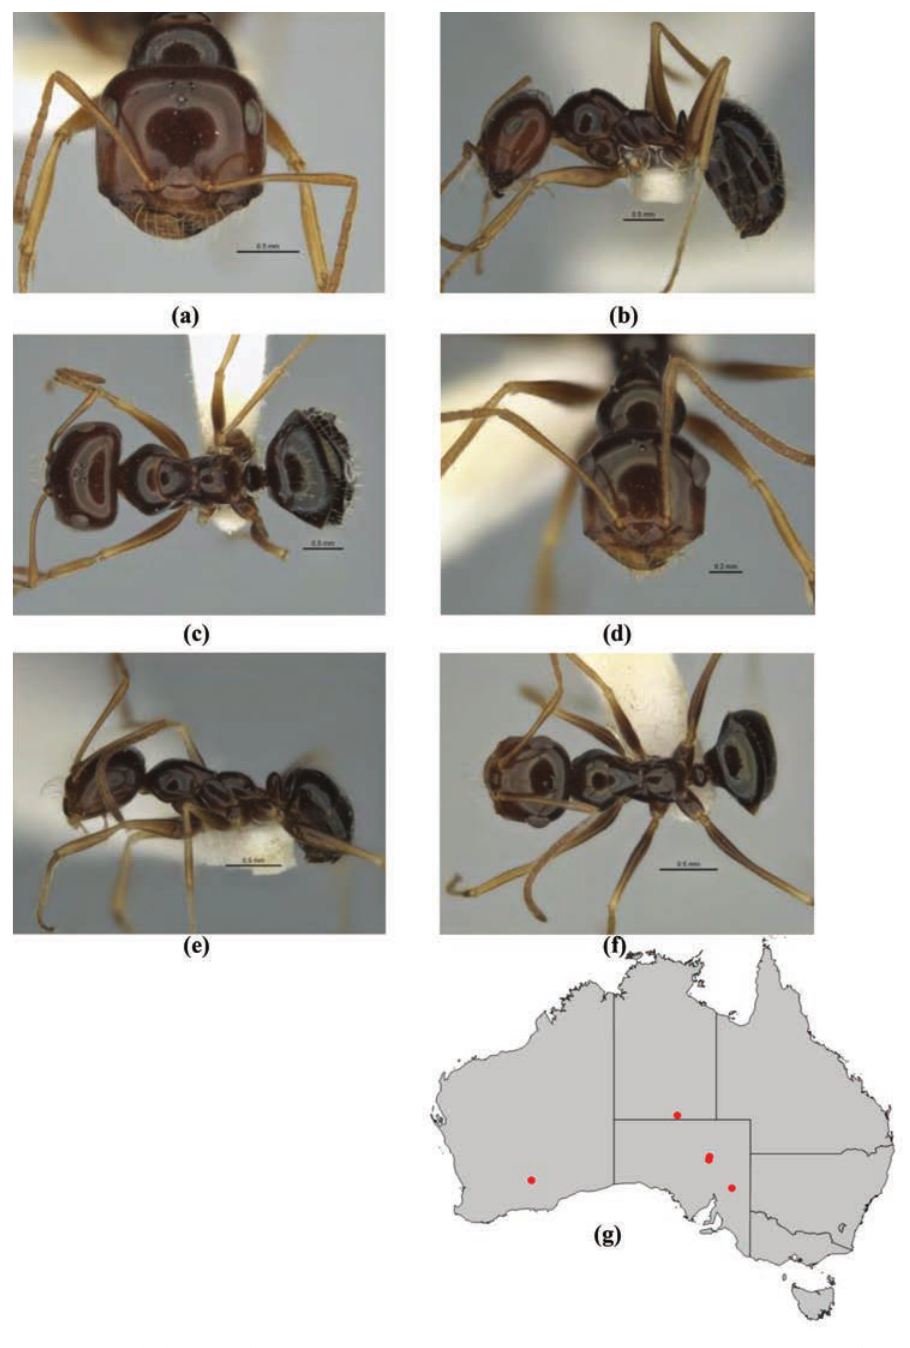
Figure 61. Melophorus isaiah sp. n.: major worker paratype (ANIC32-900184–top ant) frons ( a ), profile ( b ) and dorsum ( c ); minor worker holotype (ANIC32-900184–bottom ant) frons ( d ), profile ( e ) and dorsum ( f ); distribution map for the species ( g ). Low resolution scale bars: 0.5 mm ( a–c, e, f ); 0.2 mm ( d